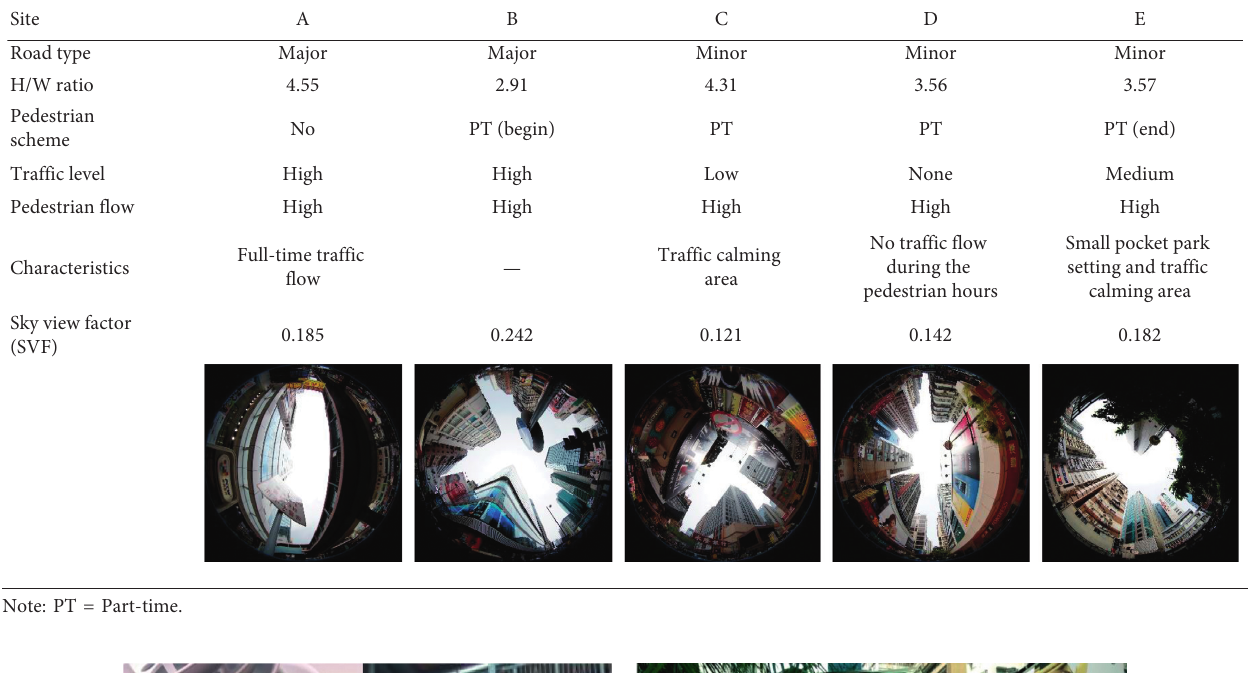
Table 1: Urbanization characteristics of five measurement locations (points A to E) with respect to the SYCSS.